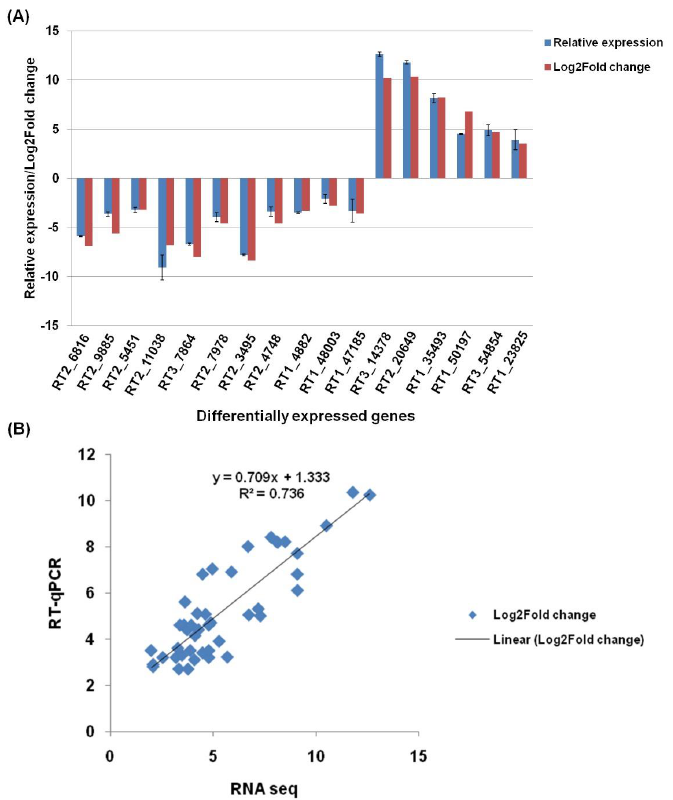
Figure 6. Relative expression of DEGs detected by qPCR and RNA seq. ( A ) Comparison of differen- tial expression of DEGs obtained by qRT – PCR and RNA Seq in GT formation versus CAT fusion